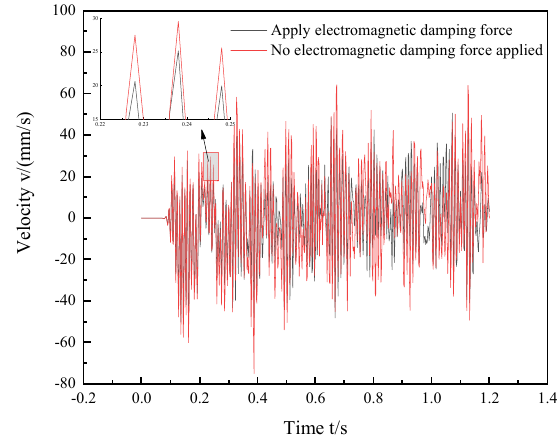
Figure 21. Speed comparison.